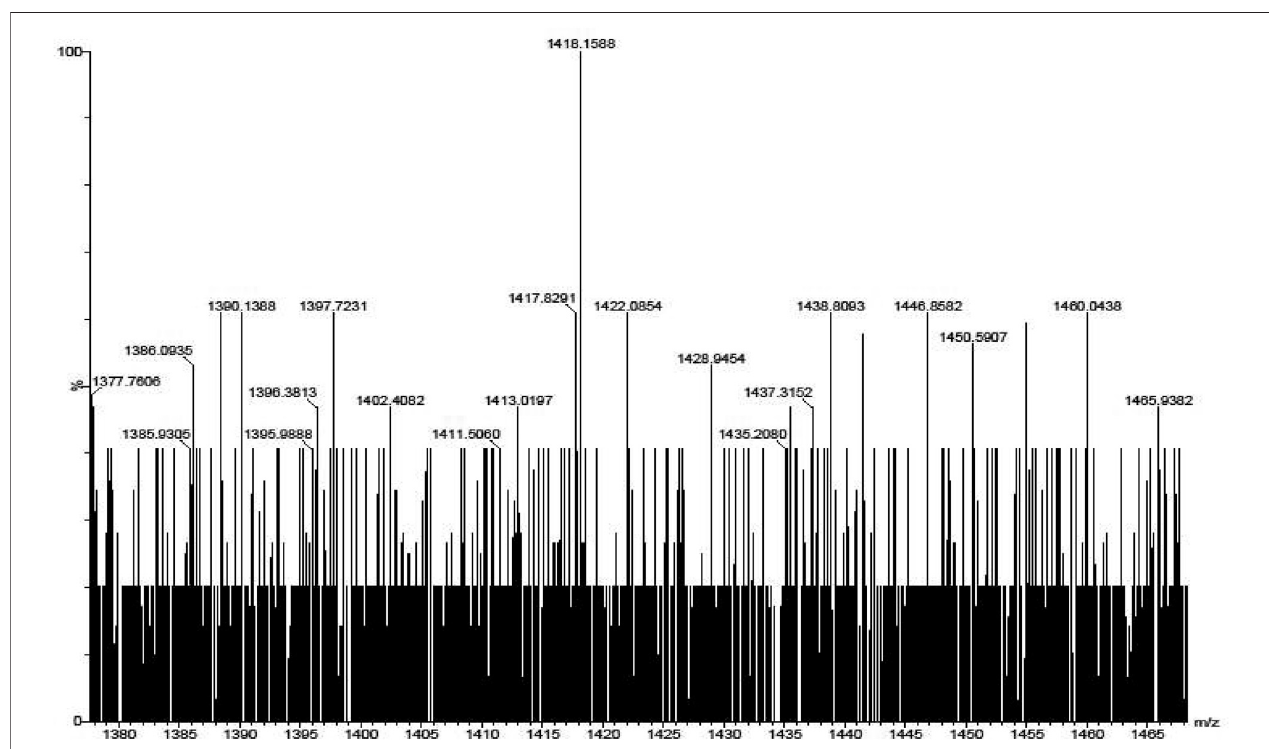
FIGURE 6 | Mass spectrum for phthalocyanine IXb with mass fragment (M-3) (cid:2) 1402.